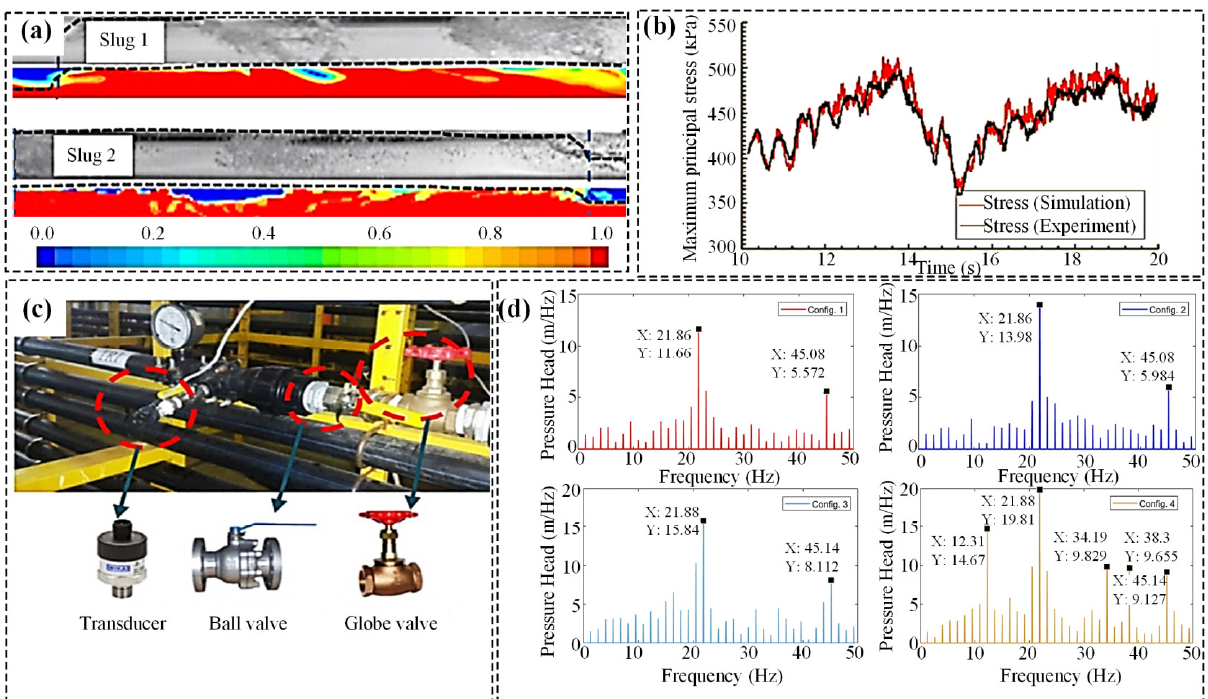
Figure 13. Vibration characters of the fluid–solid-based thin-walled shell. ( a ) Dependencies of natural frequencies and external pressures. ( b ) Cylindrical shell model and its stress feature. (Reprinted with permission from Ref. [108]. 2020, Elsevier). ( c ) Pipe with complex constraints. ( d ) Frequency response of the cylindrical shell under excitation. (Reprinted with permission from Ref. [109]. 2020, Elsevier).